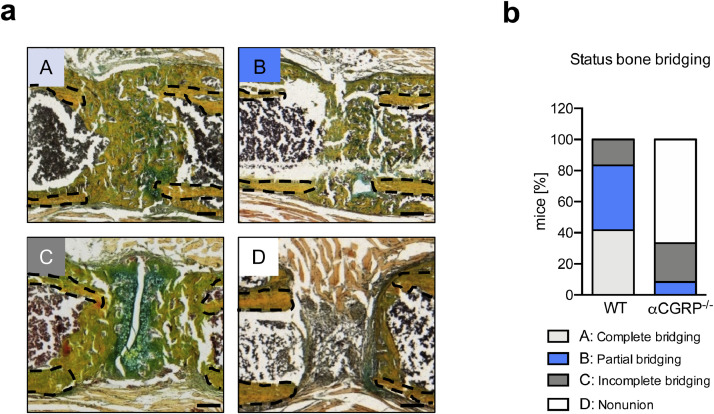
High rate of fracture non-union in αCGRP-deficient mice. (a) Exemplary callus images (Movat Pentachrome staining) representing the different outcomes of callus union at day 21 following Fx: A = complete bridging (all four cortices bridged by callus), B = partial bridging (two to three cortices bridged by callus), C = incomplete bridging (callus present, but no bridging visible), and D = non-union (rounded cortices, minimal presence of callus). Black dotted line indicates fractured bone cortices within the developing callus. (b) Semiquantitative evaluation of callus bridging in WT and αCGRP-deficient mice at the indicated time points. n = 6 mice per group. Scale bars = 200 μm.